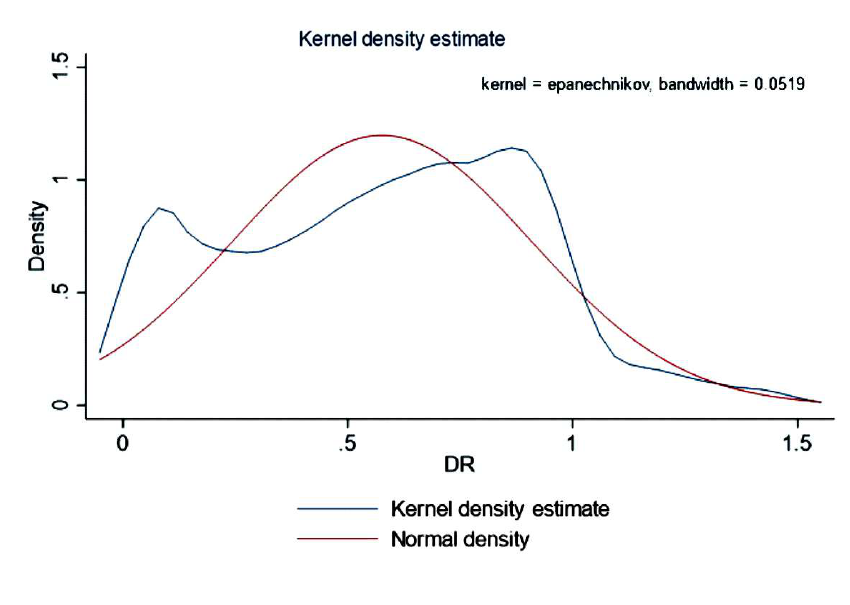
Figure 4. Kernel density estimate of Return on Equity